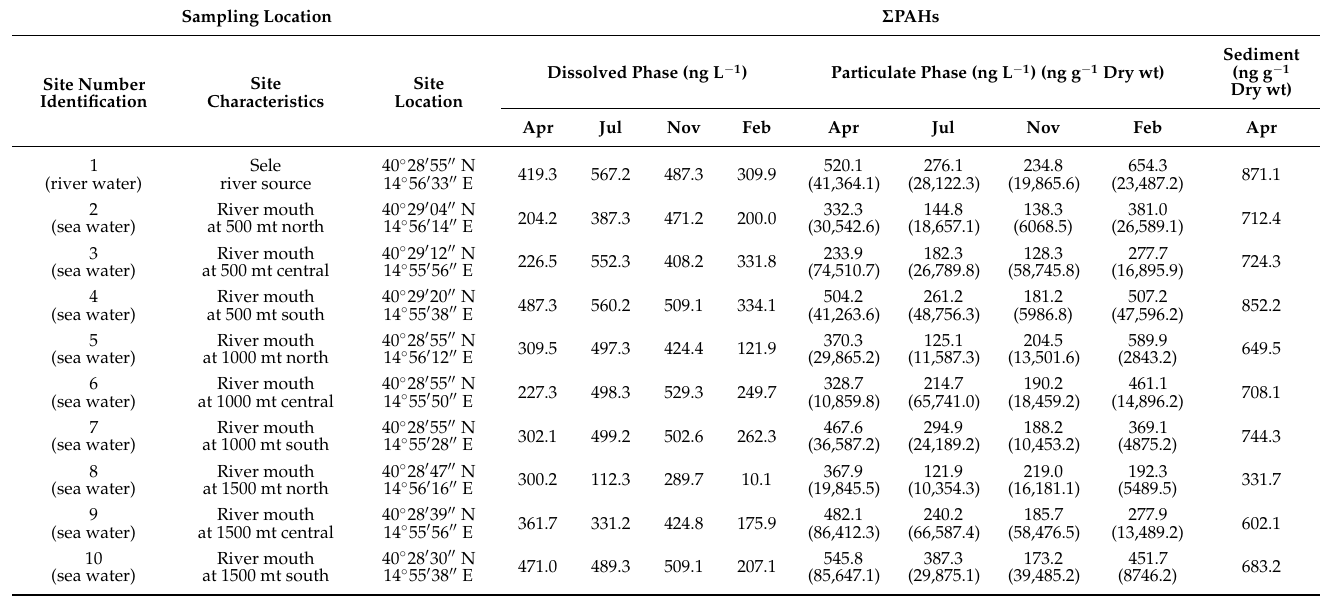
Table 1. Description of the sampling sites and concentrations of PAHs in the water-dissolved phase (DP), suspended particulate matter (SPM), and sediment of the Sele River, southern Italy. (The values in brackets represent the values of PAH concentrations in SPM expressed in ng g − 1 dry wt, after drying the filters in an air-heated oven and weighing